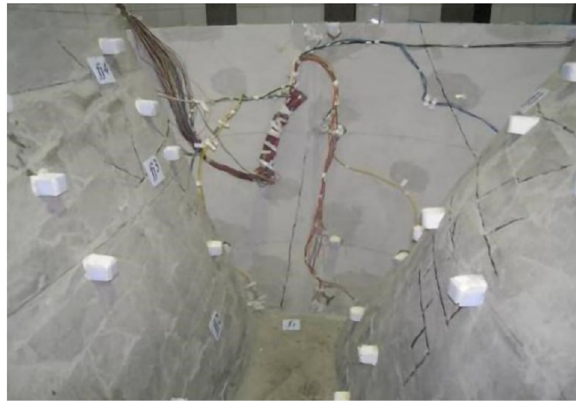
Figure 13: Schematic diagram of failure mode of downstream arch dam surface.